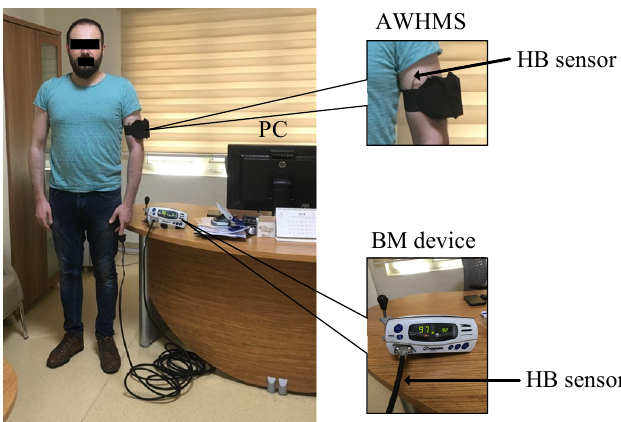
Figure 6. Connection the heartbeat sensors to the fingertip for the BM device and to the upper arm for the AWHMS. J. Sens. Actuator Netw. 2019 , 8 , x FOR PEER REVIEW